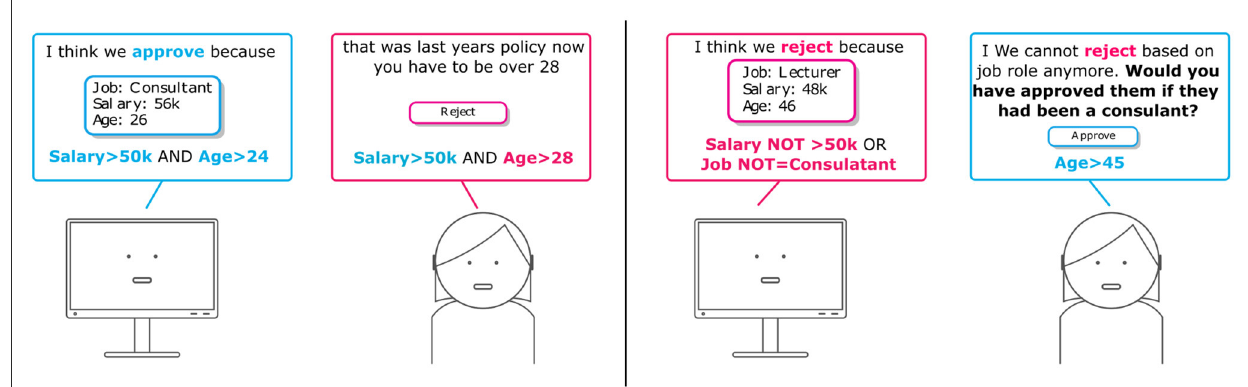
FIGURE3 Illustration of rule-based explanation feedback. (Left) Rule-based explanations shown to the user to support the prediction. (Right) The input instance does not satisfy any rules to support approve, so the clauses the input instance violates can be shown so the user can validate whether those reasons should be